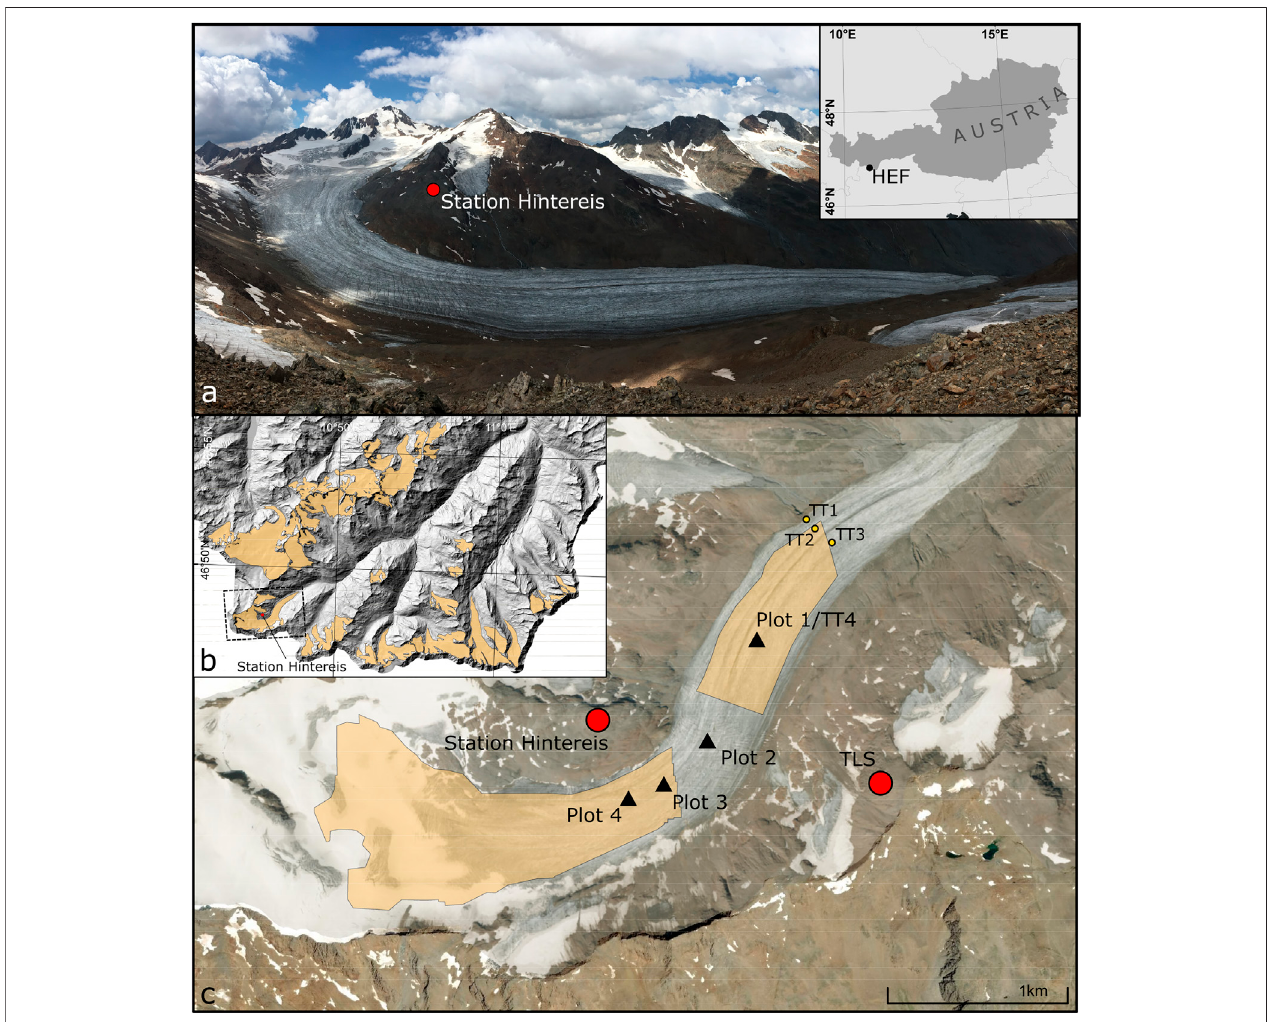
FIGURE 1 | Location of Hintereisferner (HEF). (A) A digital photograph taken from the TLS installation with the location of HEF within Austria (inset). (B) The Ötztal Alpsregion, Tyrol,usingpart oftheALSDEMused inthisstudy(Open DataAustria, 2020),highlightedwithpolygonsofglaciers > 0.5 km 2 (Buckeletal.,2018). (C) Aerial imagery of HEF (ESRI; Orthophoto Tirol) with plot locations, upper/lower glacier TLS scan regions, Station Hintereis research base (2,964 m a.s.l.) and TLS (3,244 m